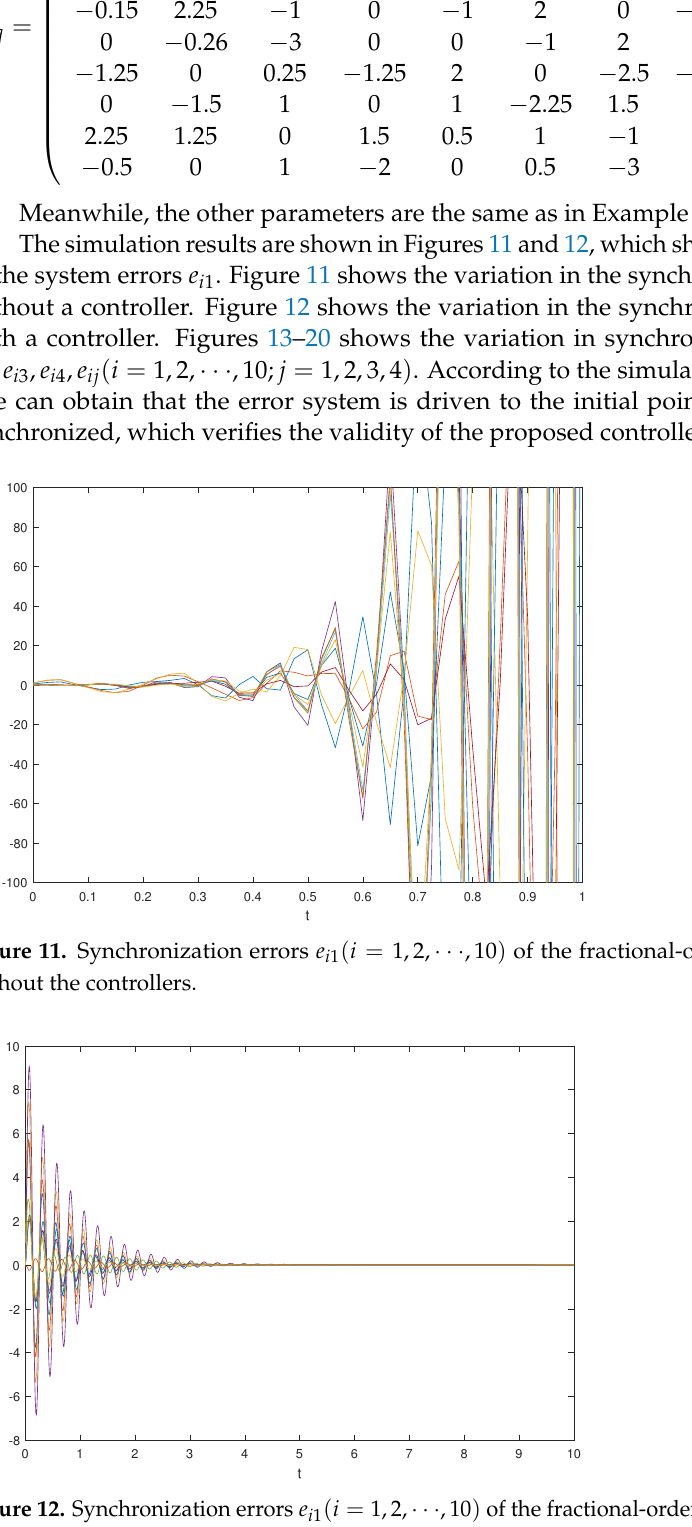
Figure 12. Synchronization errors e i 1 ( i = 1,2, · · · ,10 ) of the fractional-order system (34) and (35) with the